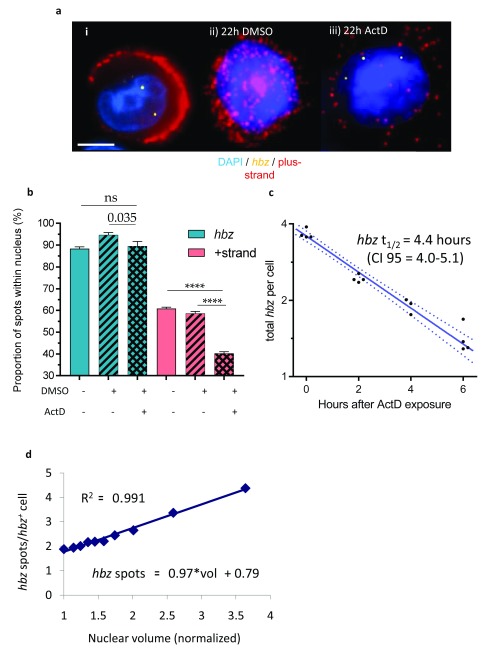
plus-strand RNA is exported from the nucleus, whereas the majority of
hbz is retained.
a. Representative images showing i) an optical slice illustrating the difference in cellular localisation of plus-strand RNA and
hbz, ii) a typical plus-strand
-high cell after 22 hours in DMSO and iii) a cell after 22 hours in actinomycin D. Image a.i is a single slice from a z-stack whereas ii and iii are maximum projections. Scale bar is 5 µm.
b.
hbz mRNA remains largely intranuclear, whereas plus-strand mRNA is mostly cytoplasmic; this difference is accentuated by blocking transcription with actinomycin D. n = 936 untreated, 390 DMSO-treated and 195 actinomycin D-treated cells, each from two pooled biological replicates of clones A and B.
c. Rate of disappearance of total
hbz spots following treatment with actinomycin D. The slope of the log-transformed data is the rate of decay. Individual measurements from replicates are shown, along with a linear regression and 95% confidence intervals (dashed lines); one of the four replicates failed at the 4 hour mark. n = 8126 total cells.
d. Mean
hbz spot count in
hbz-positive cells was strongly correlated with nuclear volume.